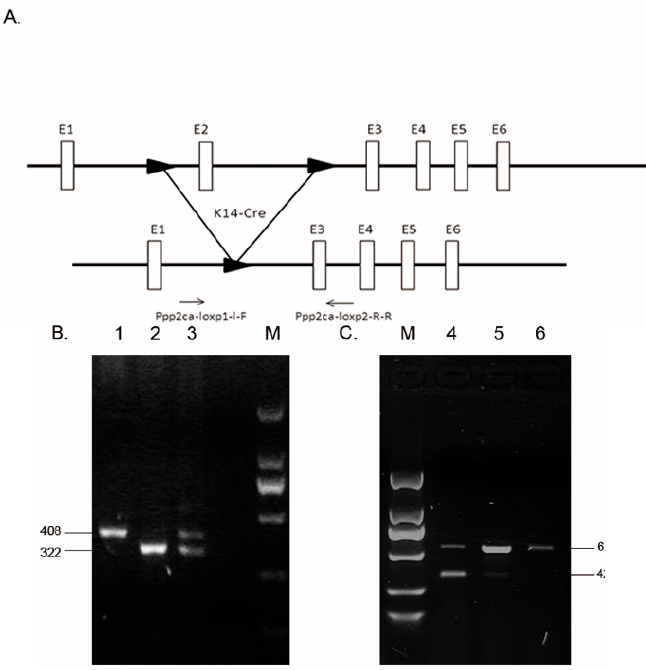
Figure 1. Cont. Figure 1.